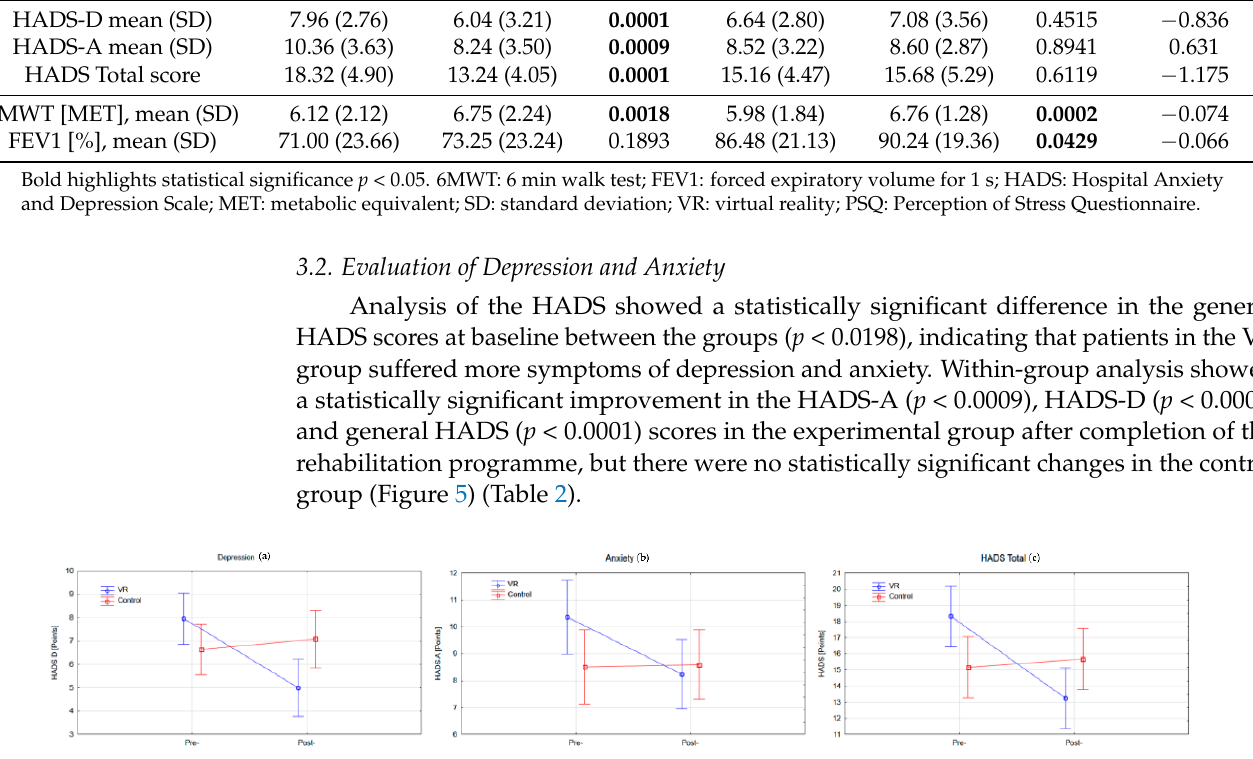
Figure 5. Analysis of the HADS (Hospital Anxiety and Depression Scale) questionnaire in both groups pre- and post- rehabilitation program: ( a ) depression, ( b ) anxiety, and ( c ) total score.